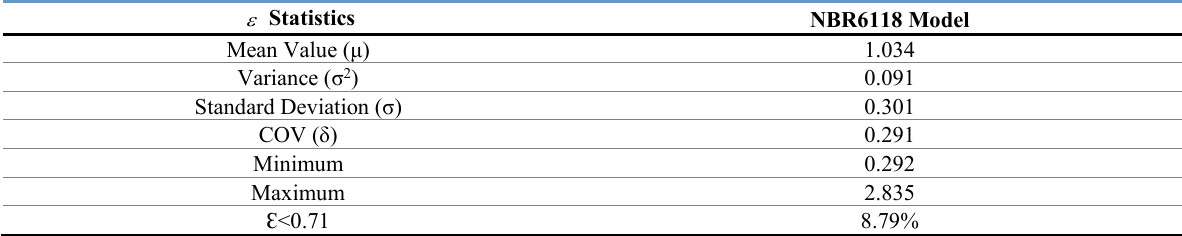
Table 2. Statistics of the model error for the NBR6118 model.